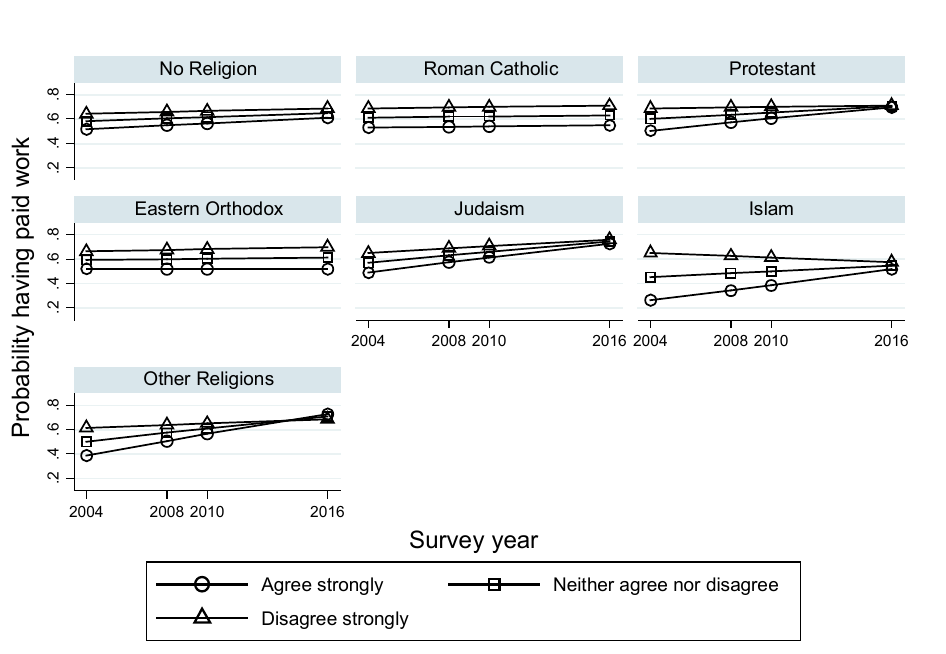
Figure 4 : Average predicted probabilities from model results. Gender attitudes (“ Men should have more right to a job than women when jobs are scarce ”) in the employment of women belonging to different religions between 2004 and